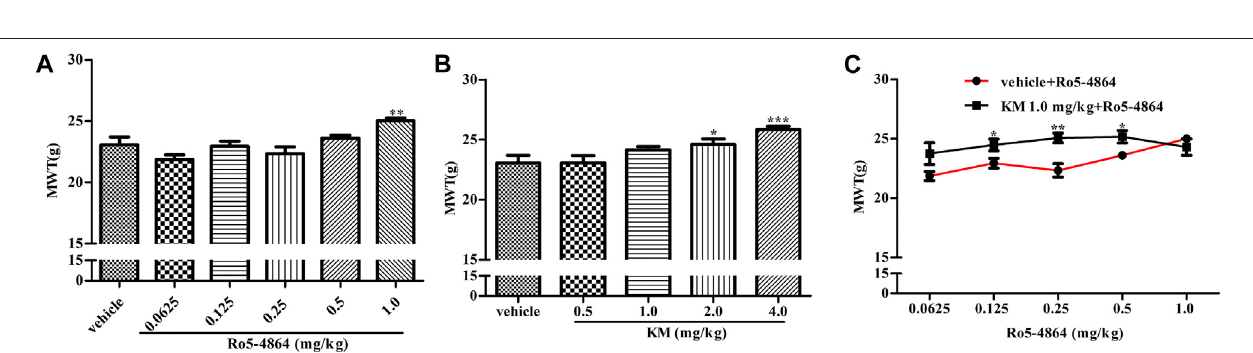
FIGURE 5 | Modulation of the in vivo ef fi cacy of Ro5-4864 by koumine acute administration in the rat model of CIA. (A,B) Effects of acute administration of Ro5- 4864 (A) or koumine (B) on the MWT. (C) Dose response effects on the MWT of Ro5-4864 in the absence or presence of koumine (1.0 mg/kg). Seven-week-old Lewis rats were immunized with bovine type II collagen in IFA. Immunized rats received Ro5-4864, koumine or vehicle on day 29 after the fi rst collagen injection. Koumine or vehicle was injected s. c., and the MWT was determined 60 min after koumine injection. Ro5-4864 or vehicle was injected i. p., and the MWT was determined 50 min after Ro5-4864 injection. To determine whether koumine potentiated the effects of Ro5-4864, koumine (1.0 mg/kg, s. c.) or vehicle was injected 10 min before Ro5-4864 (0.0625 – 1.0 mg/kg, i. p.) injection, and the MWT was determined 50 min after the last injection. Abbreviations; KM: koumine, MWT: mechanical withdrawal threshold.Dataarerepresentedasthemean ± SEM,* p < 0.05, ** p < 0.01, *** p < 0.001vs. thecorresponding vehicle group. Statisticalanalysisin (A,B) wereperformed using one-way ANOVA followed by the LSD post hoc test and in (C) was performed using the independent samples t -test. Each group consisted of 7 – 11 rats.